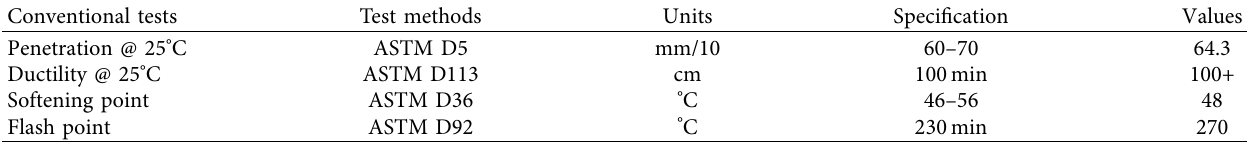
Table 1: Physical properties of 60/70